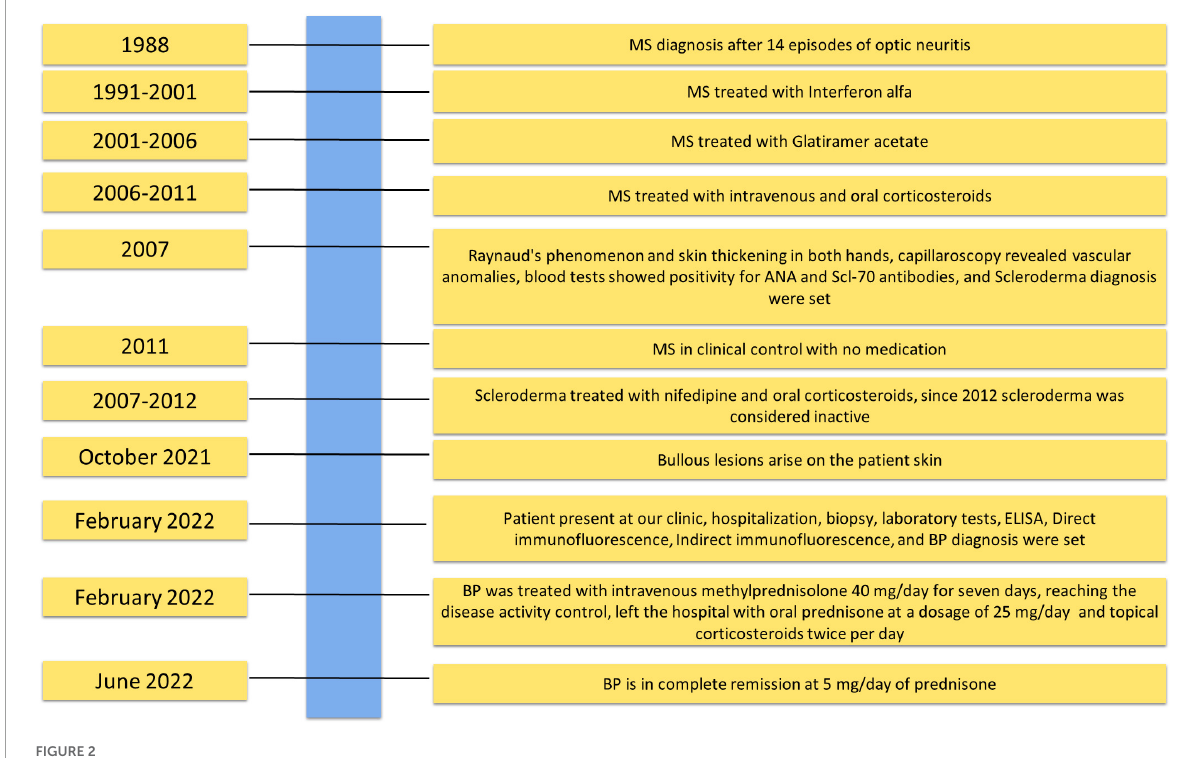
FIGURE2 Timeline with relevant data about the onset, diagnosis, and therapy of bullous pemphigoid